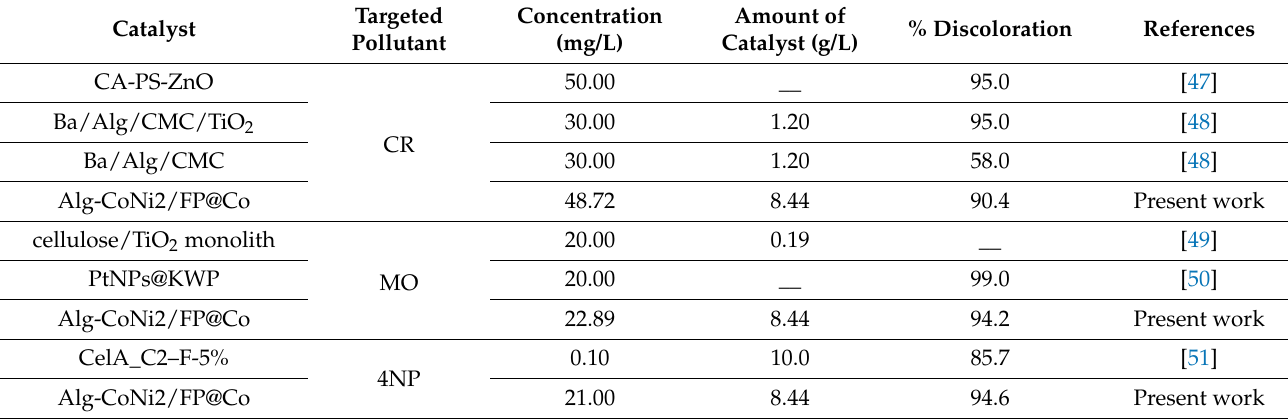
Table 4. Comparative literature data for CR, MO, and 4NP degradation with the present